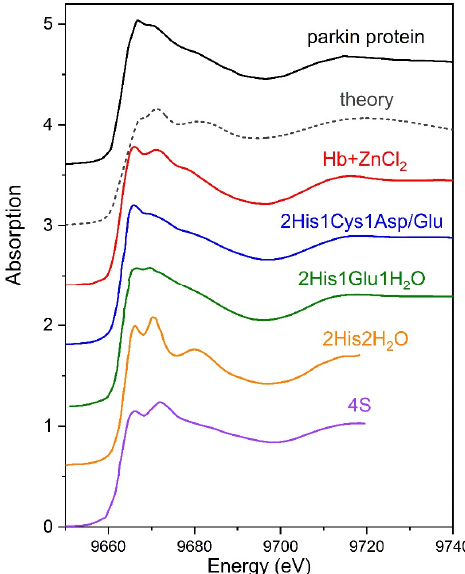
Figure 3. Comparison of XANES spectra at the Zn K-edge for the parkin protein layer adsorbed at the liquid interface and experimental data available in the literature [19–22]. Dashed line, calculations. For clarity, the curves are offset vertically.